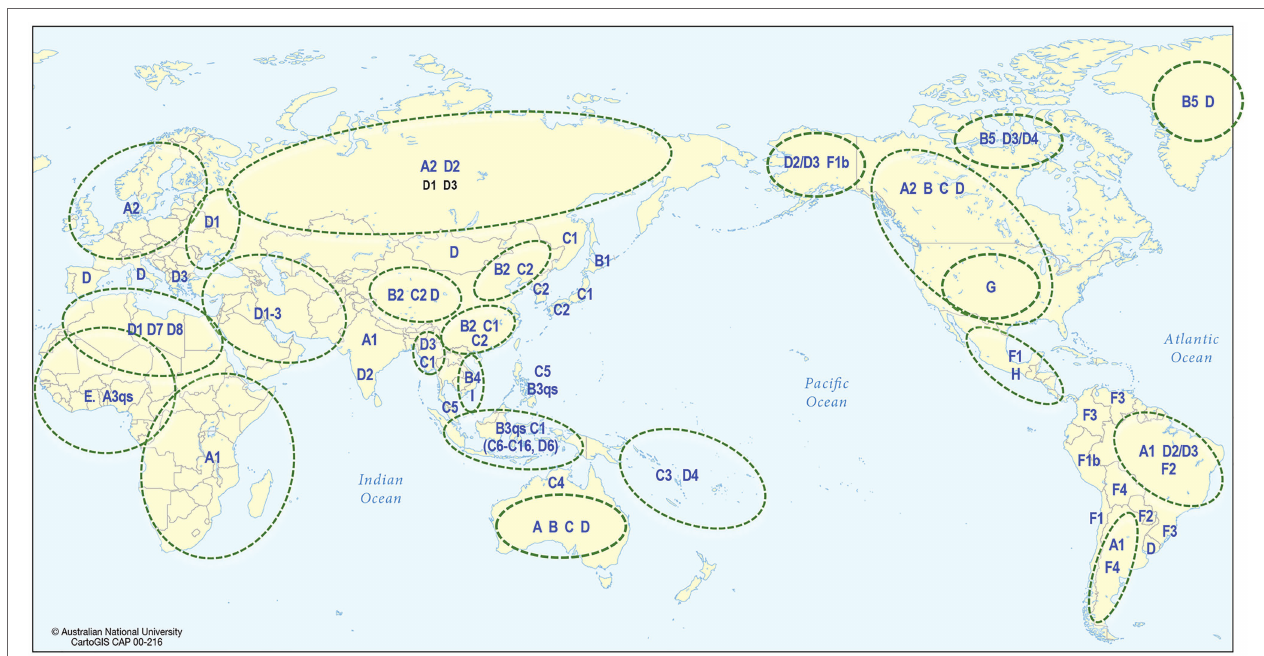
FIGURE 5 | Global distribution of HBV. The map shows the predominant genotype and subgenotypes that have been identified in different countries around the